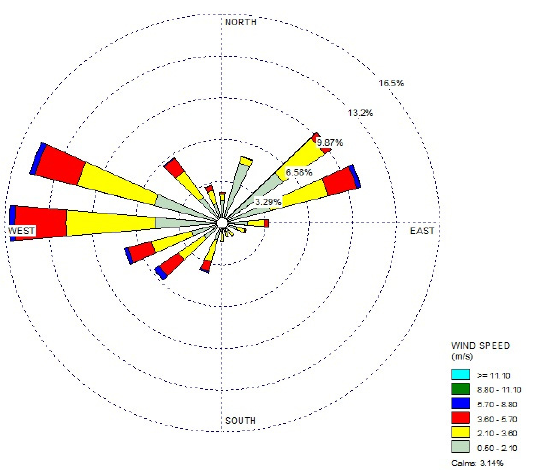
Figure 1. A wind rose diagram showing the pattern of wind speed and direction.